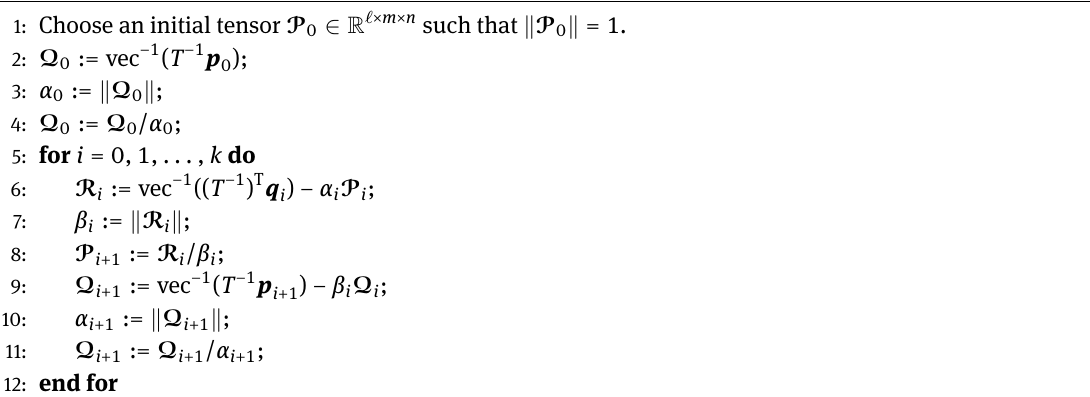
Algorithm 2 A Lanczos bidiagonalization method over tensor space for T